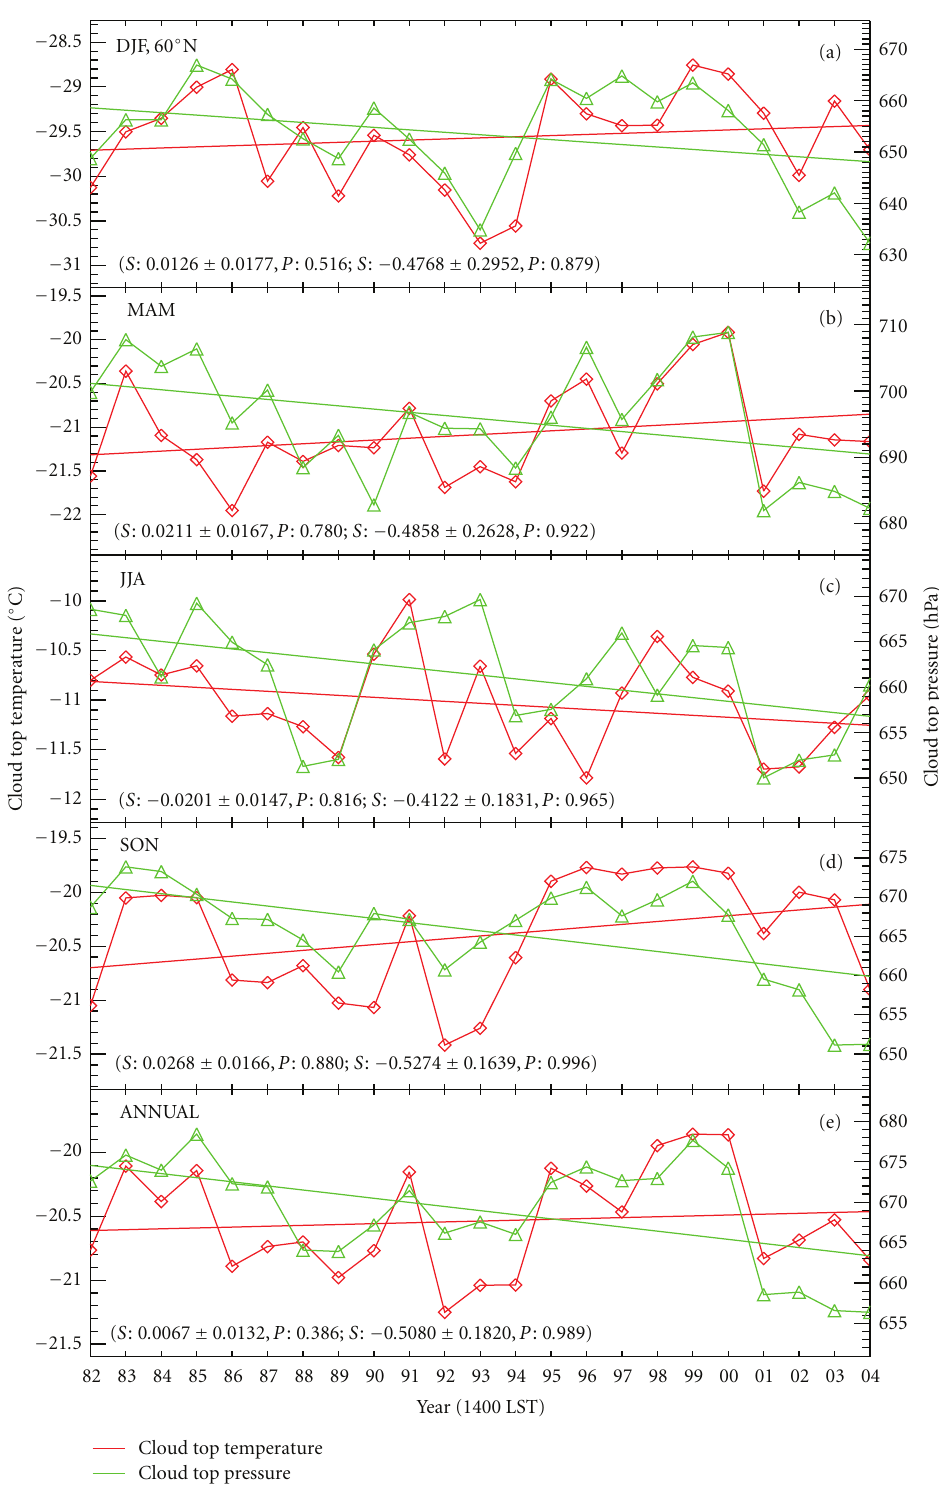
Figure 9: As in Figure 3, but for cloud top temperature and pressure. The first pair of S and P denotes the cloud top temperature trend (red) and the second pair is for the cloud top pressure trend